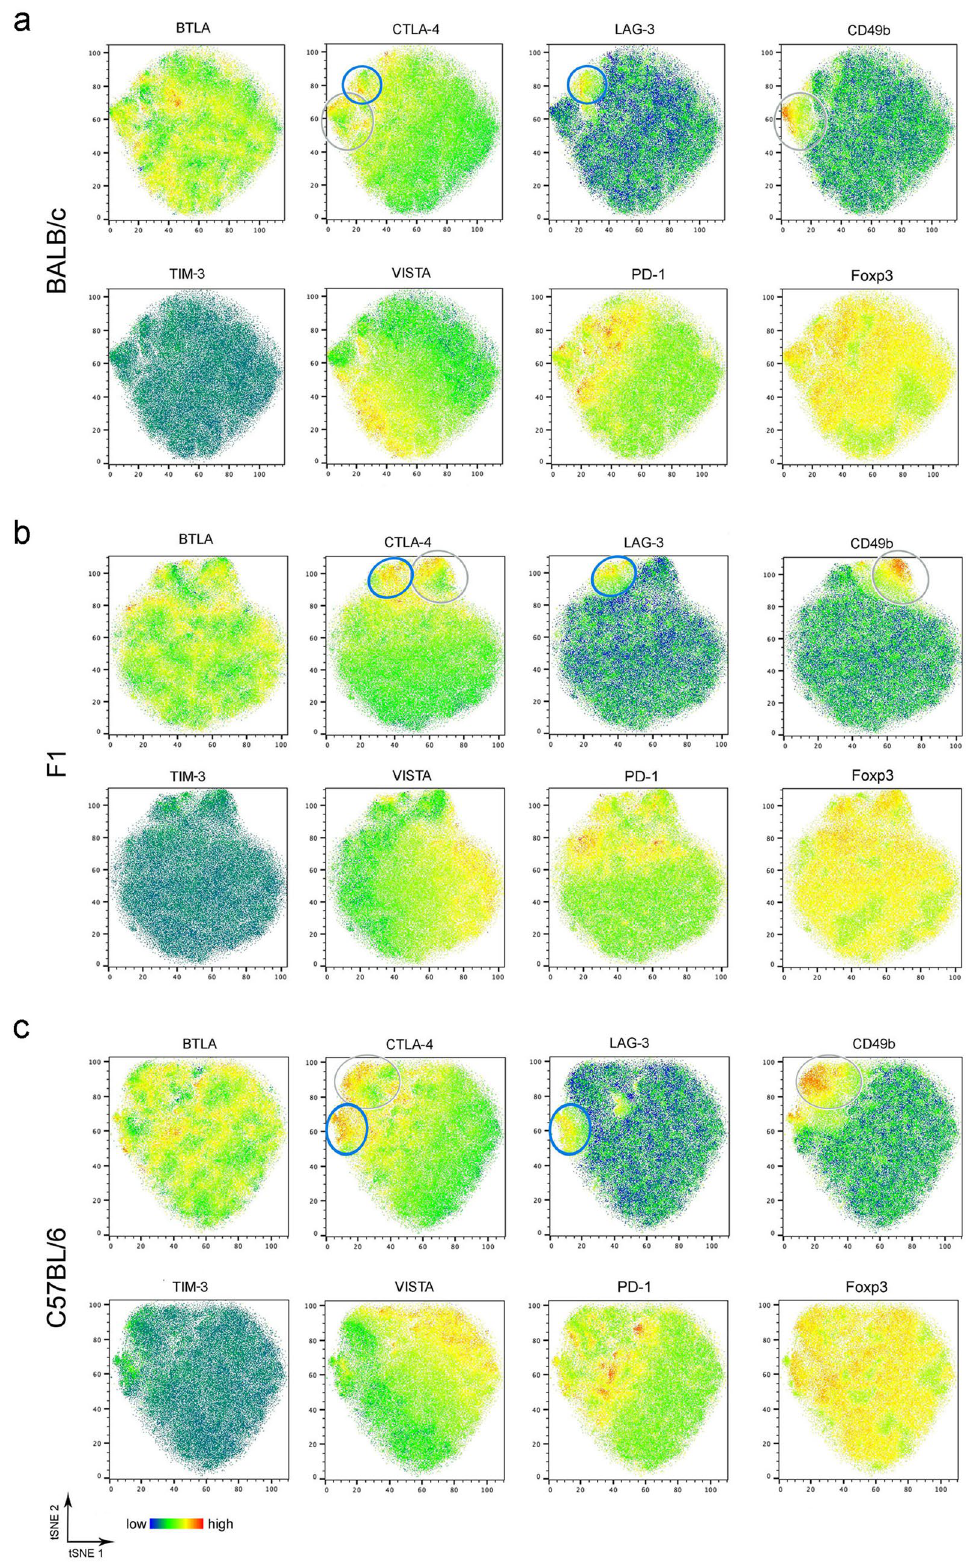
Figure 3. Similar expression pattern of regulatory markers by Treg from BALB/c, F1 and C57BL/6 mice. BALB/c, F1 and C57BL/6 mice were infected with 2000 iL3. Six days later mes LN were isolated and stained with a panel for regulatory receptors. t-SNE calculation was performed with 40,000 Foxp3 + CD4 + Treg using FlowJo Plugins. Representative t-SNE heatmaps derived from Treg from BALB/c ( a ), F1 ( b ) and C57BL/6 ( c ) showing the expression of BTLA, CTLA-4, LAG-3, CD49b, TIM-3, VISTA, PD-1 and